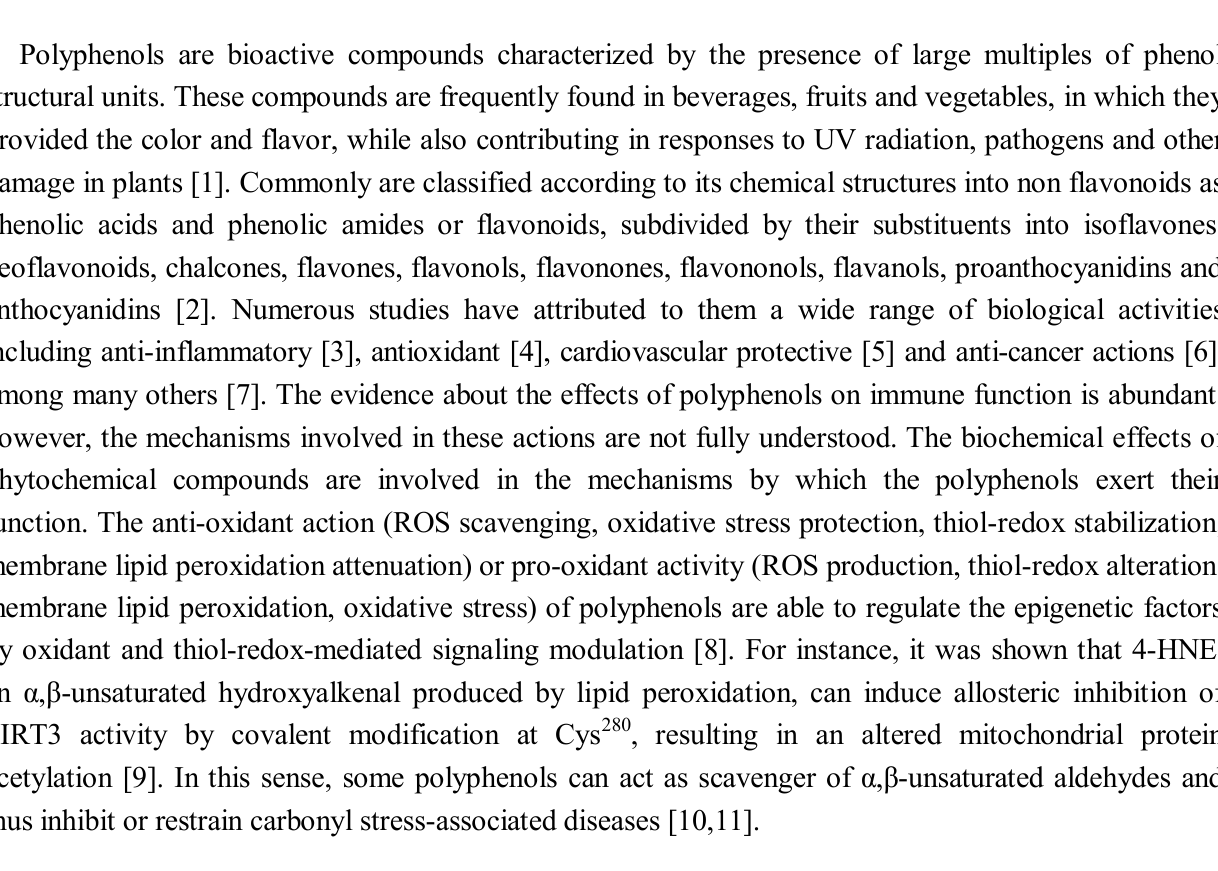
Figure 1. Chemical structures of different polyphenols involved in the modulation of epigenetic